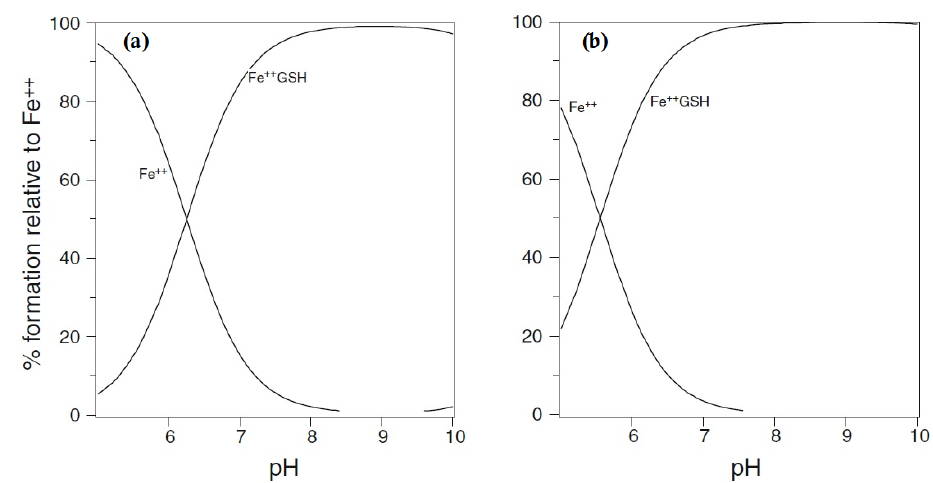
Figure 1. Speciation plots of iron(II) (1 µ M) with glutathione: ( a ) glutathione [GSH] = 2 mM and ( b ) [GSH] = 10 mM. Fe ++ is ferrous iron.